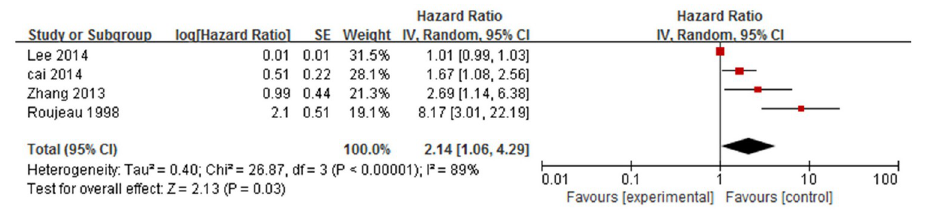
Fig 9. Forest plot of the association between the general condition and bullous pemphigoid mortality.